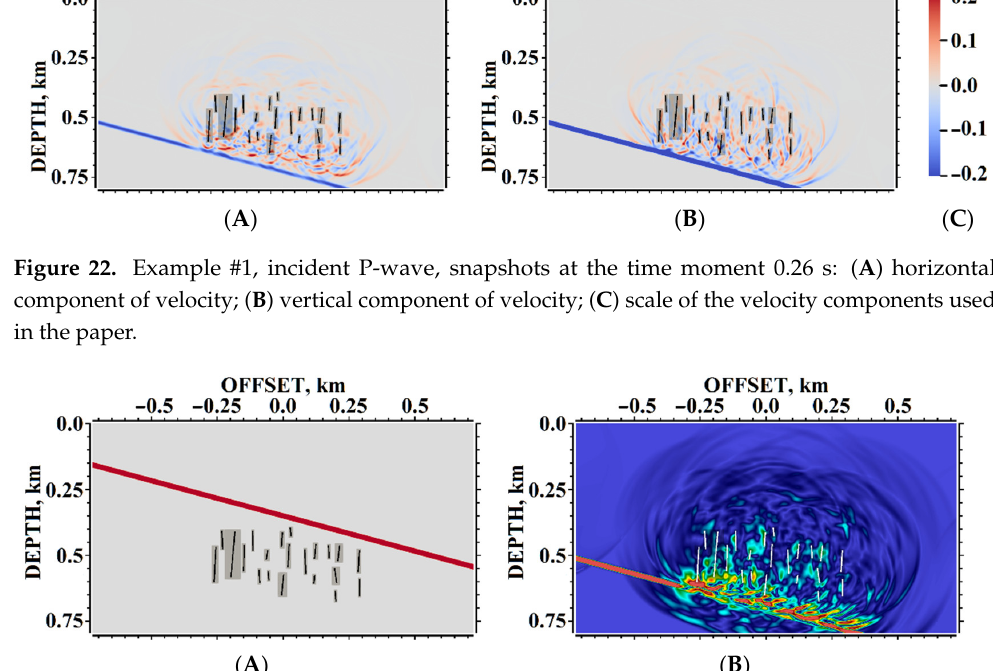
Figure 23. Example #1, incident S-wave: ( A ) geophysical model, overlapping curvilinear meshes, the incident S-wave is marked with the red line; ( B ) velocity modulus snapshot at the time moment 0.38 s.